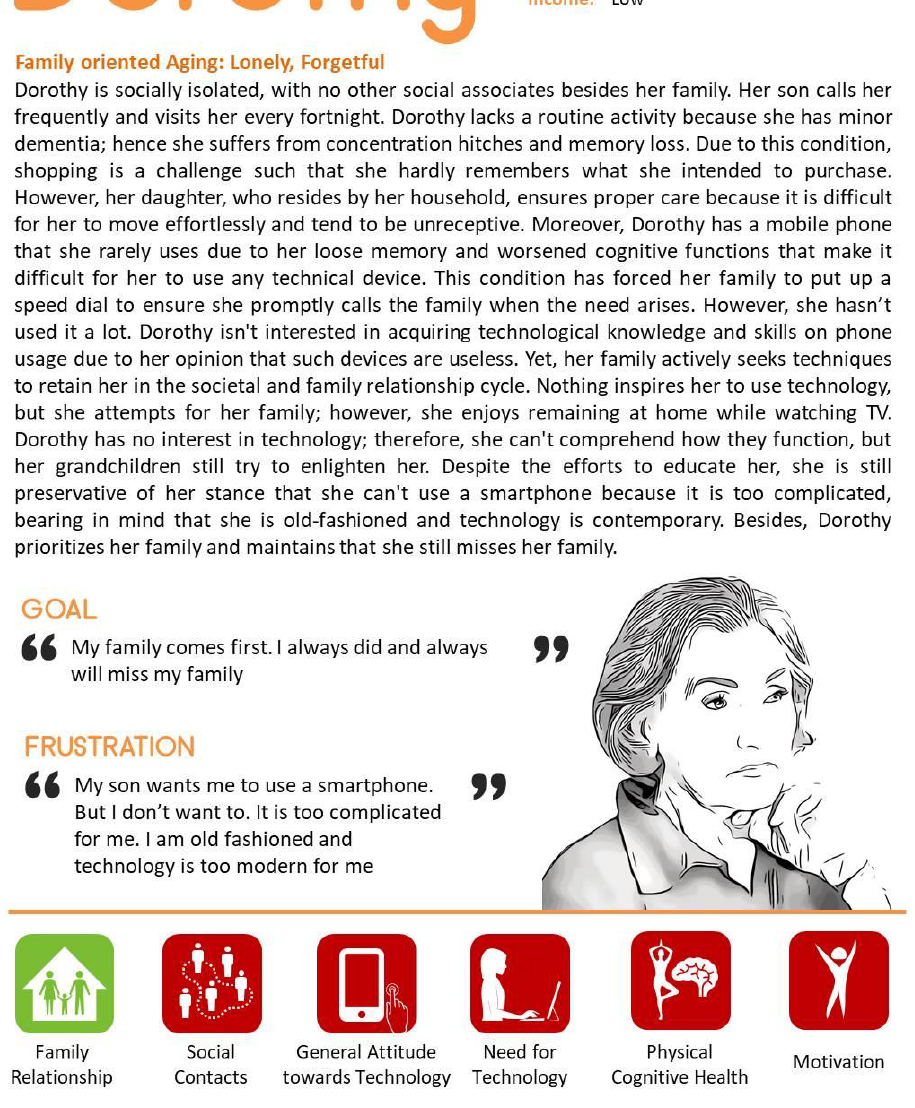
Figure 3. Case 3—Representative character to present family oriented use of technology.